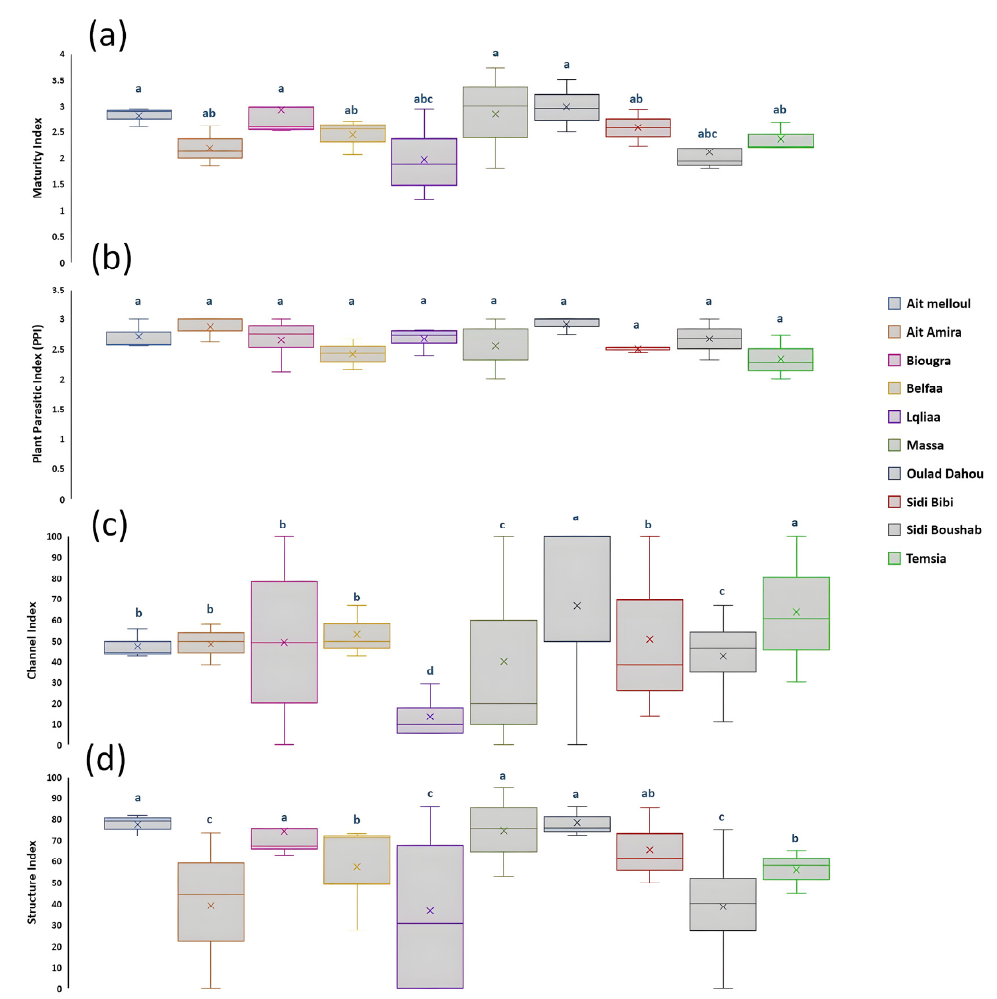
Figure 4. Nematode diversity patterns in sampled wheat fields of Southern Morocco. ( a ) Maturity index (MI); ( b ) plant-parasitic index (PPI); ( c ) channel index (CI); ( d ) structure index (SI). Letters represent homogeneous groups according to the LSD test ( p < 0.05).